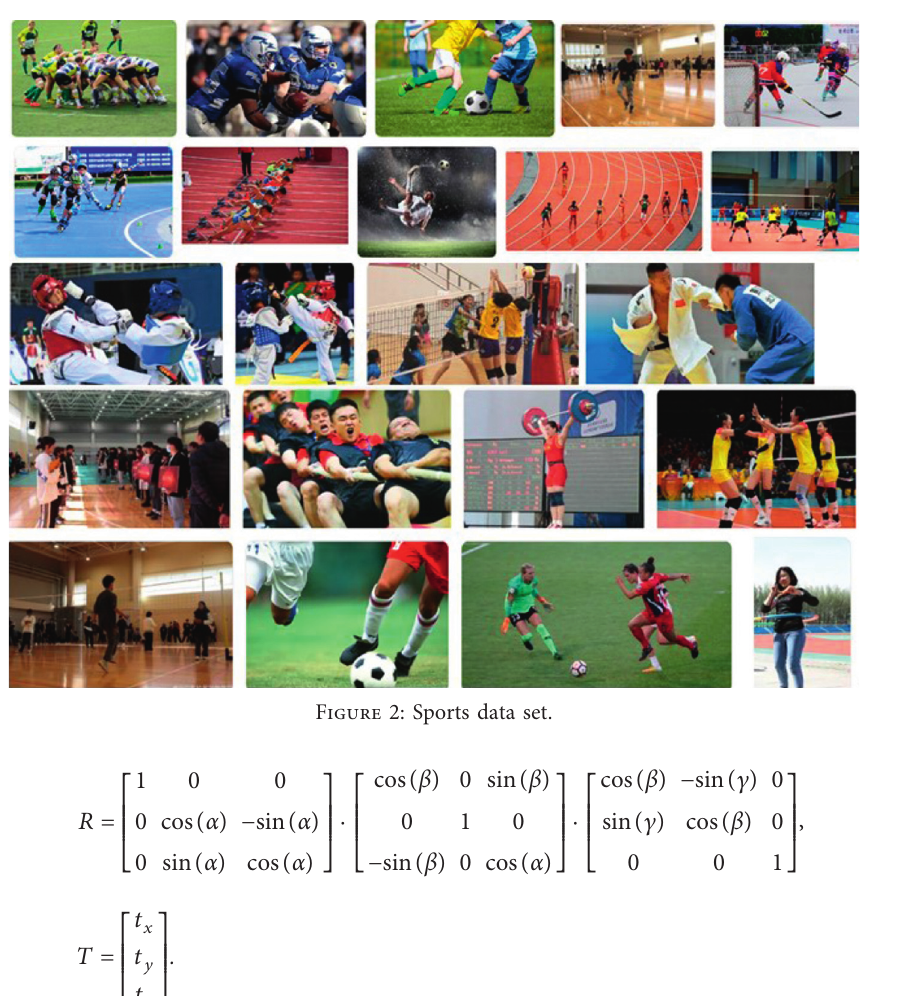
Figure 2: Sports data